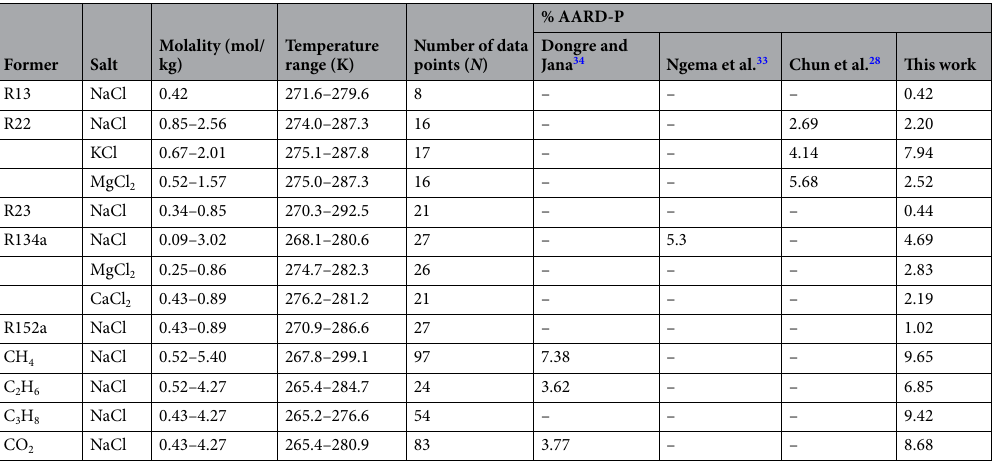
Table 7. A comparison of the %AARD-P estimate for hydrate phase equilibrium for refrigerants formers in the presence of different